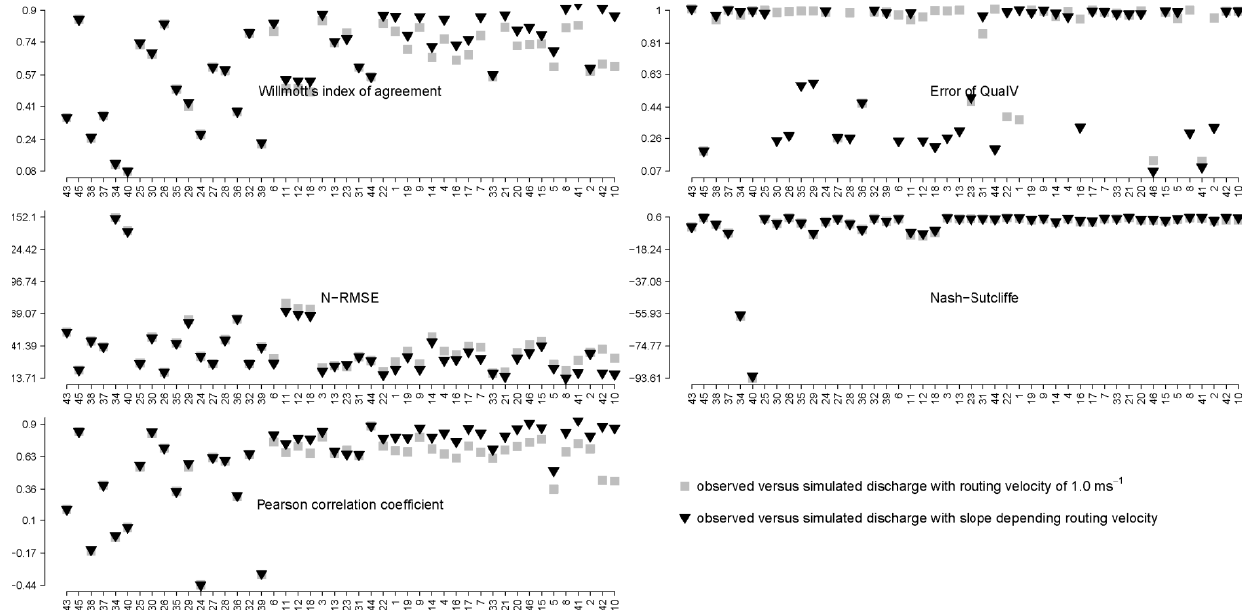
Fig. 4. Comparison of observed and simulated discharge for all 44 observation sites with 5 indices (details in Table 5). Sites are sorted according the observed mean annual discharge [m 3 s − 1 ], with the lowest discharge site at the left hand site.